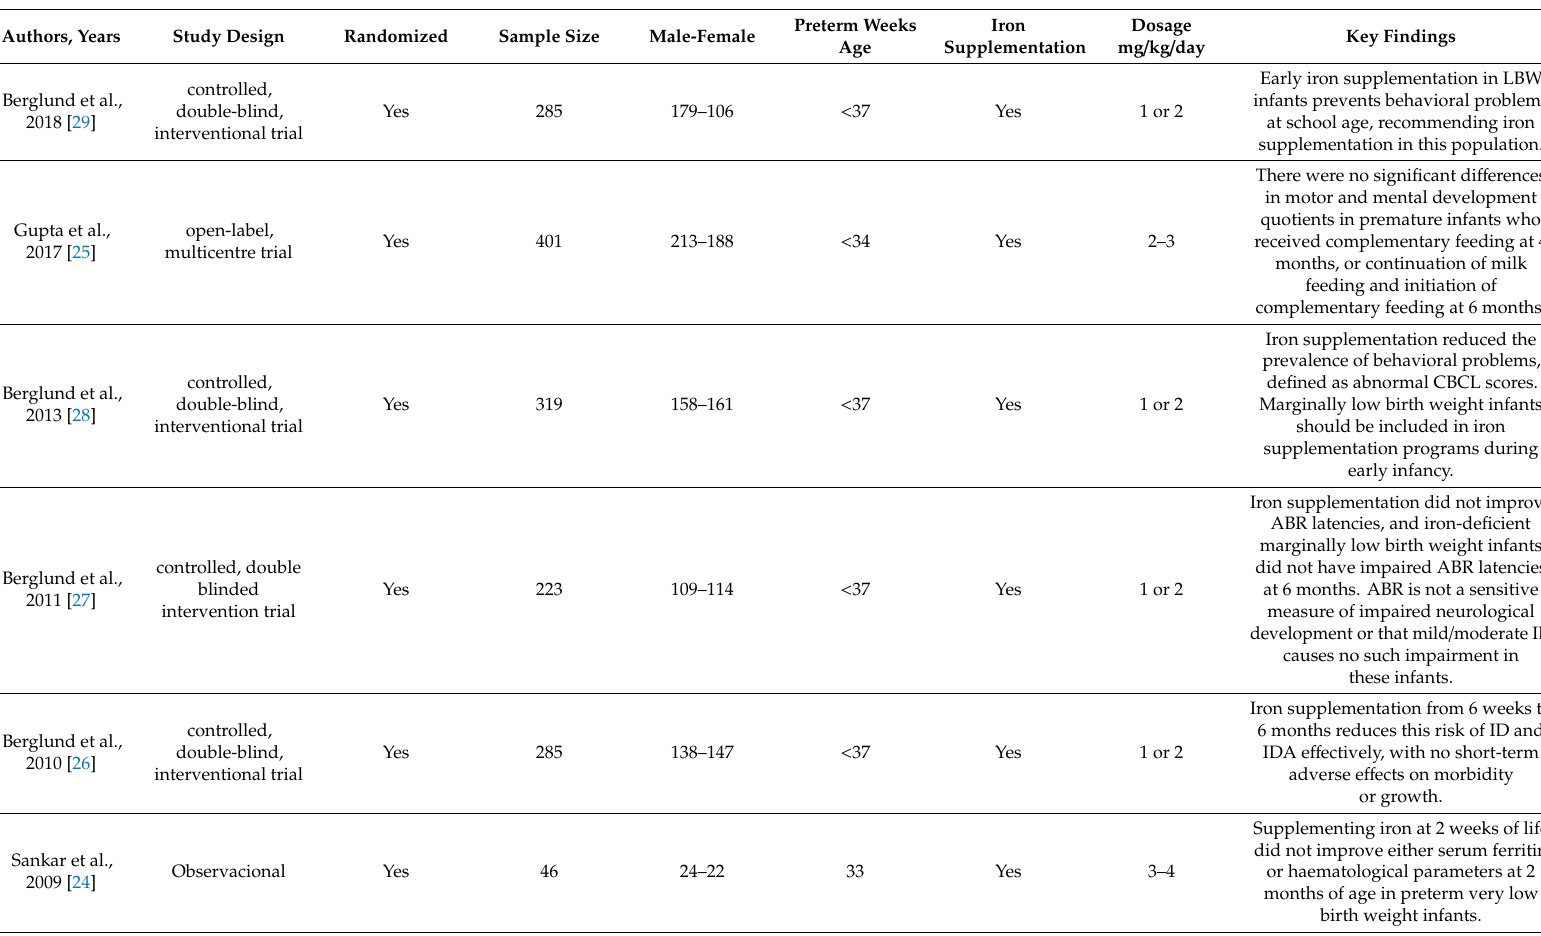
Table 3. Summary of the characteristics of the randomized studies. LBW, low birth weight; CBCL, Child Behavior Checklist; ABR, auditory brainstem response; ID, iron